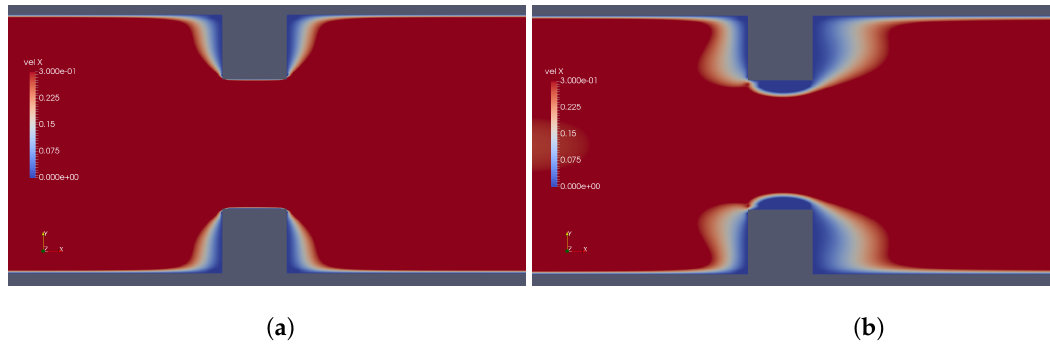
Figure 19. Downstream velocity, in ( a ) without perturbation, i.e., ω ∗ = 0 and ( b ) ω ∗ = 1.0 × 10 − 3 .